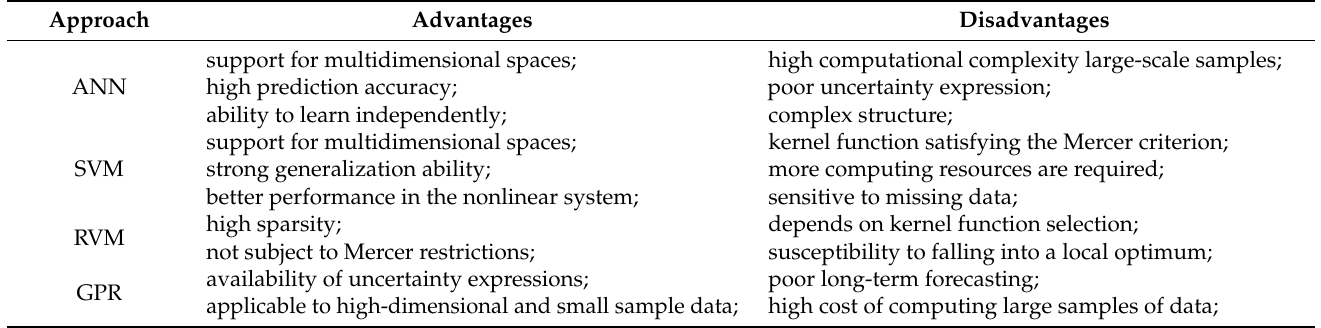
Table 1. Comparison of the advantages and disadvantages of the four data-driven